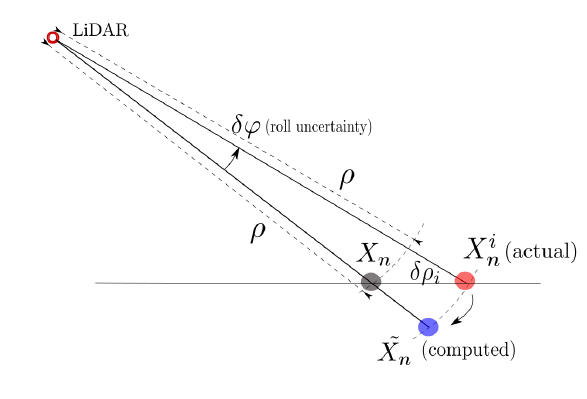
Figure 2. Range bias δρ i due to an attitude error affecting the beam pointing direction. Here, we represented the effect of a roll error δϕ . This bias depends on the local terrain